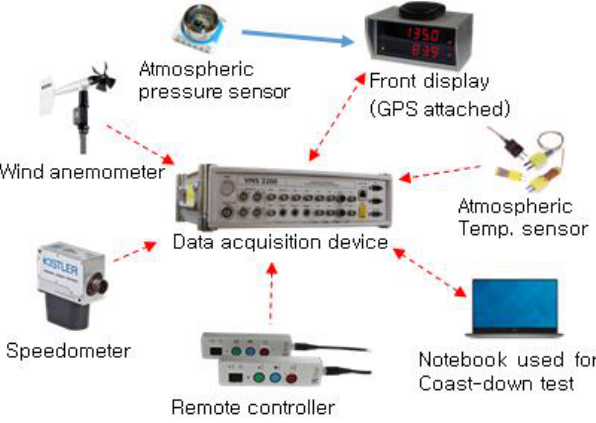
Figure 2. Measurement device configuration for coastdown.